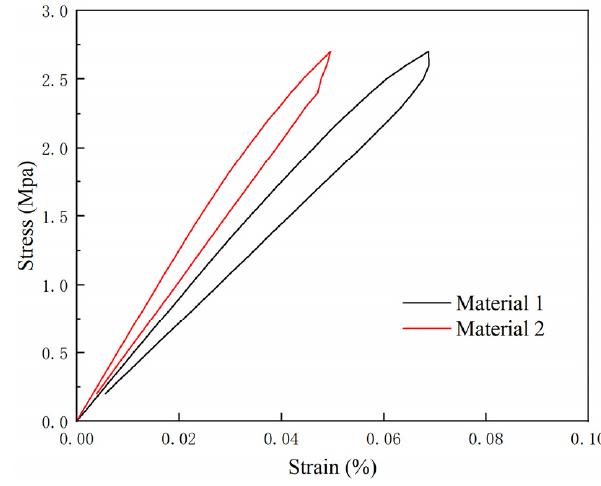
Figure 17. Experimental results for elastic energy index.